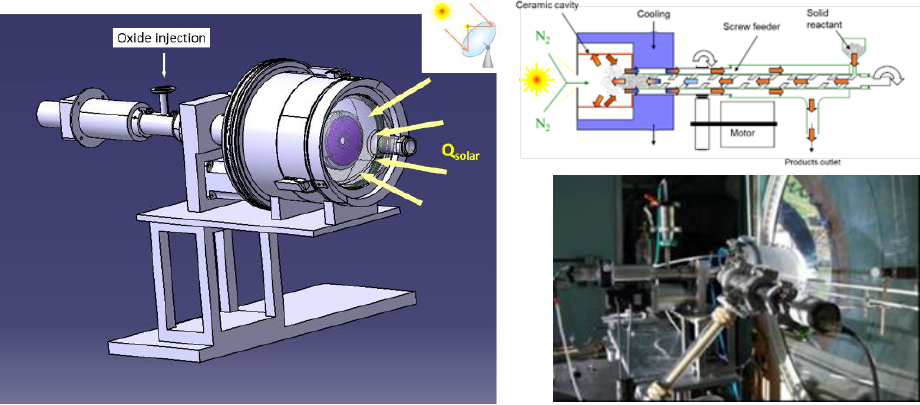
Figure 10. Continuously particle-fed solar reactor for ZnO reduction and Zn production.